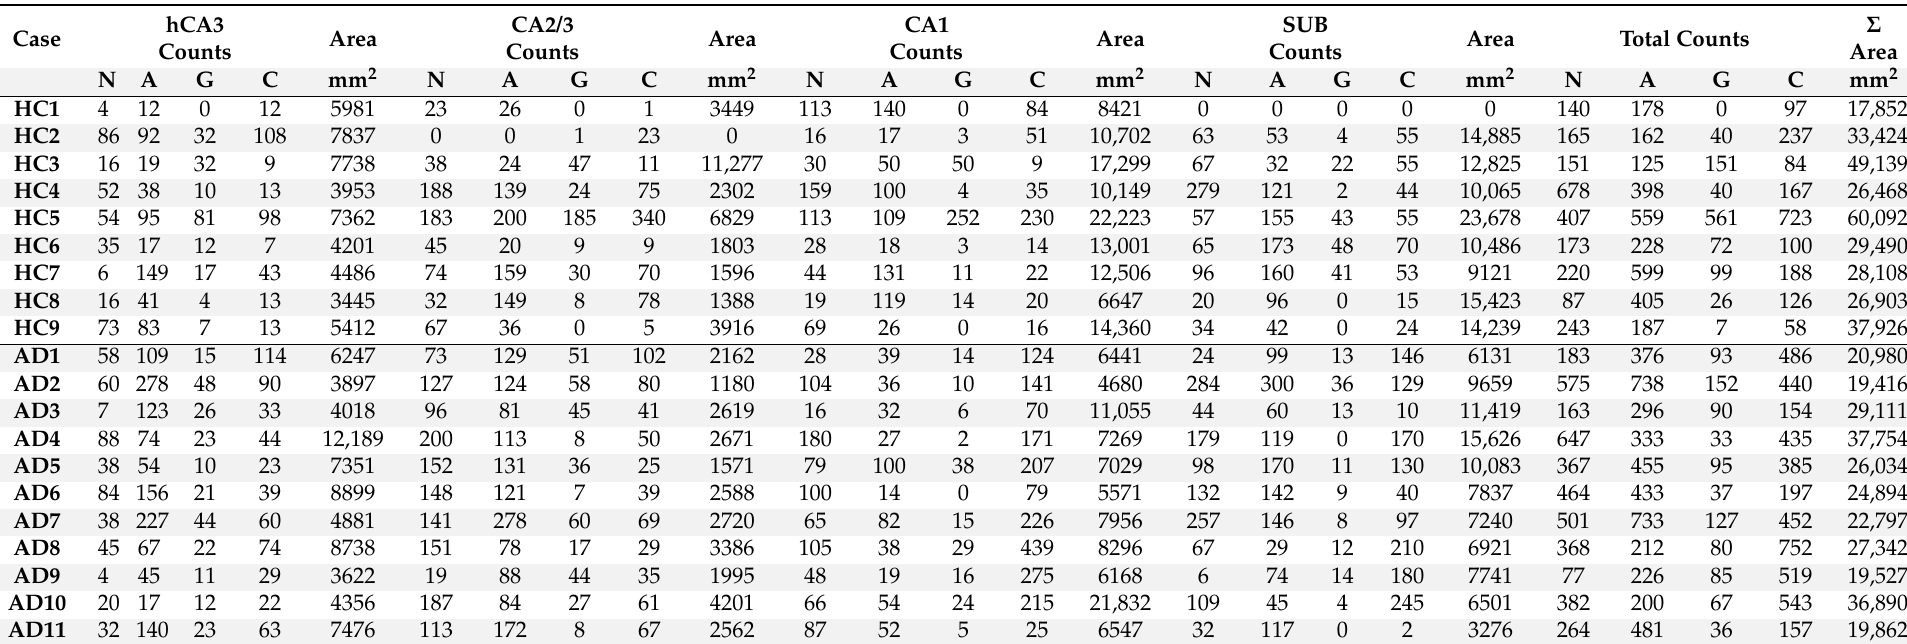
Table 2. Results of NLRP1 (N), ASC (A), cGSDMD (G), and CASP-6 (C) immunostaining assessment. Numbers represent the total number of all immunoreactive neurons in a given hippocampal subdivision in a randomly selected section of the